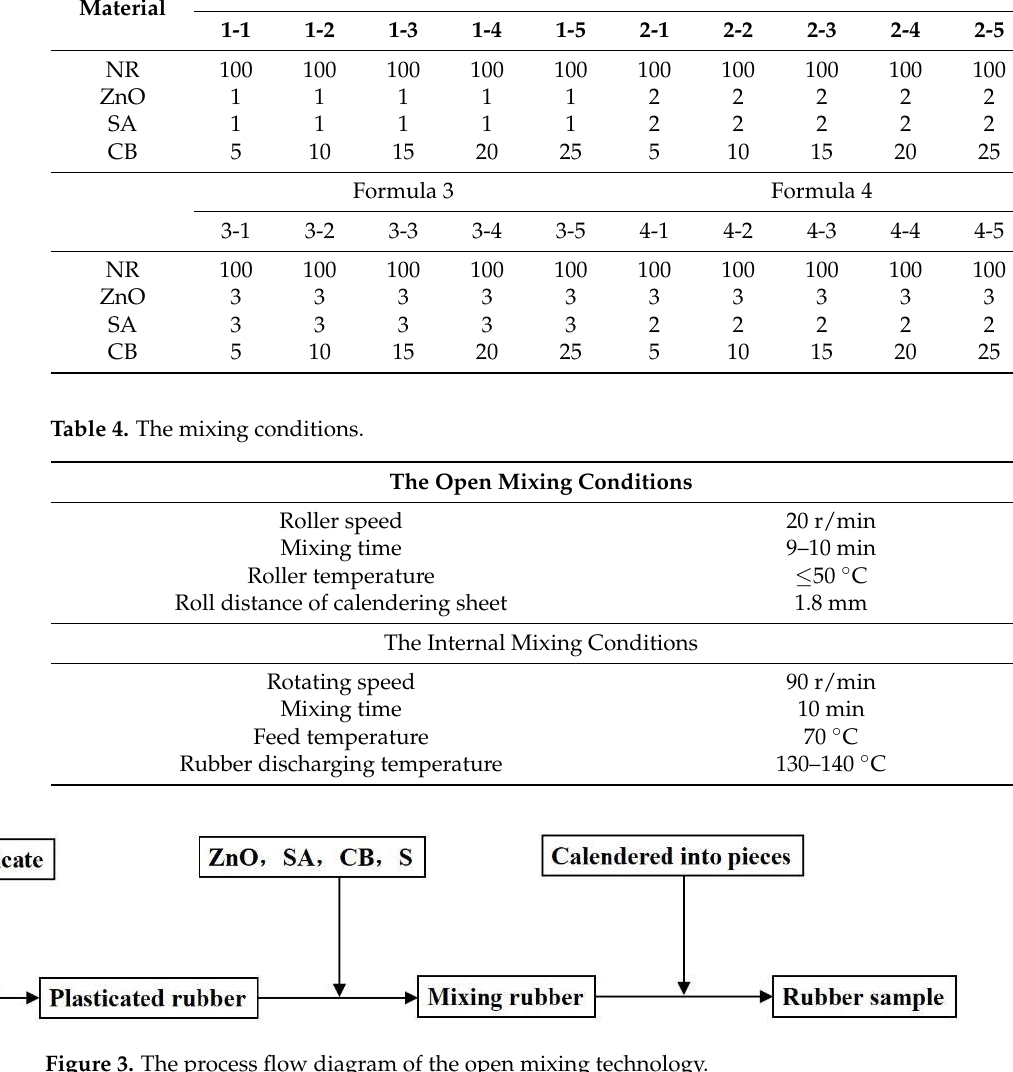
Figure 4. The process flow diagram of the internal mixing technology.